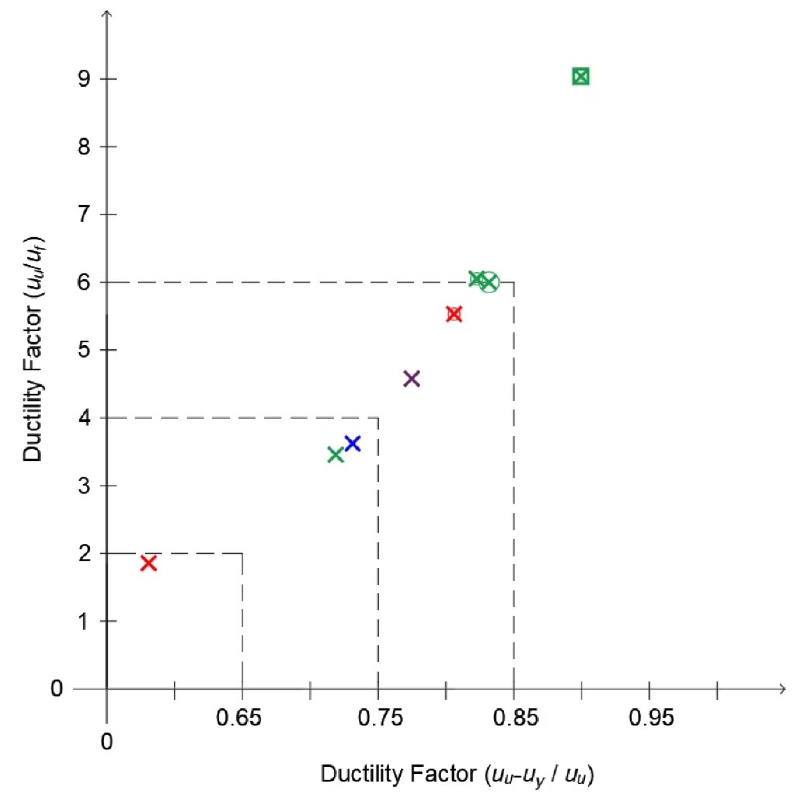
Figure 25. Comparative ductility performance of moment-resisting connections based on different ductility factors.